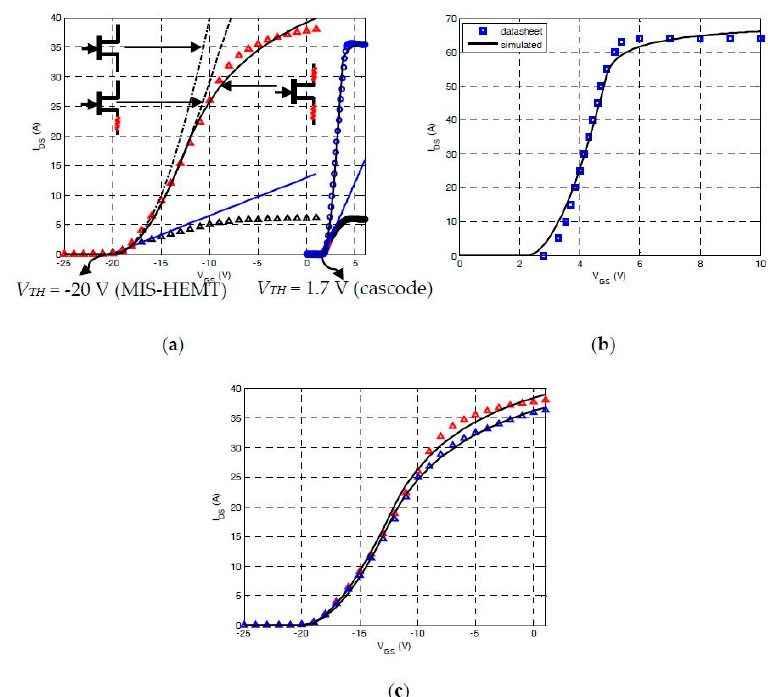
Figure 3. Transfer characteristics of ( a ) fabricated D-mode (red triangle) and cascode (blue circle) GaN FETs (the solid line indicates the SPICE simulation); ( b ) commercial cascode GaN FETs [ TPH3006PS ]; and ( c ) fabricated D-mode before (red triangle) and after high-voltage (100 V) stress (blue triangle) GaN FETs (the solid line indicates the SPICE simulation) [25].